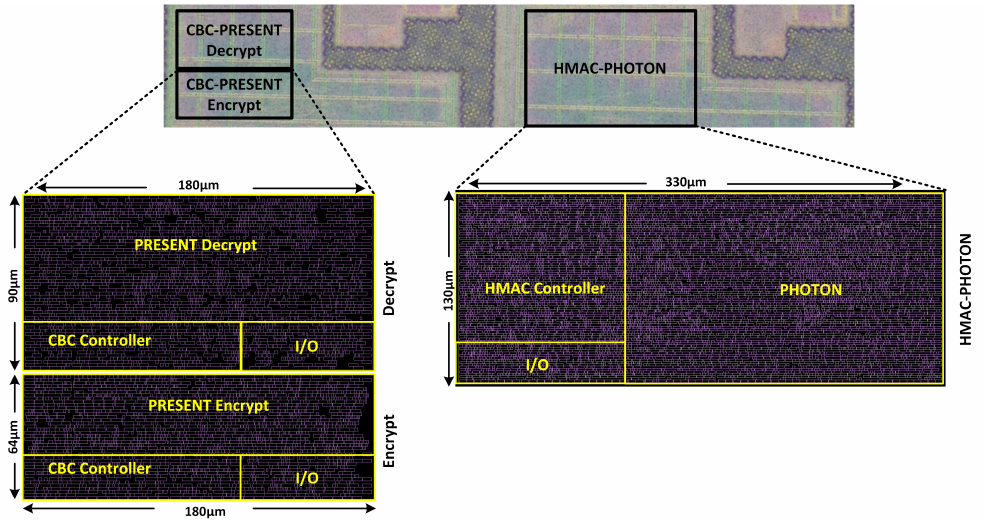
Figure 11. Die micrograph of the CBC-PRESENT &